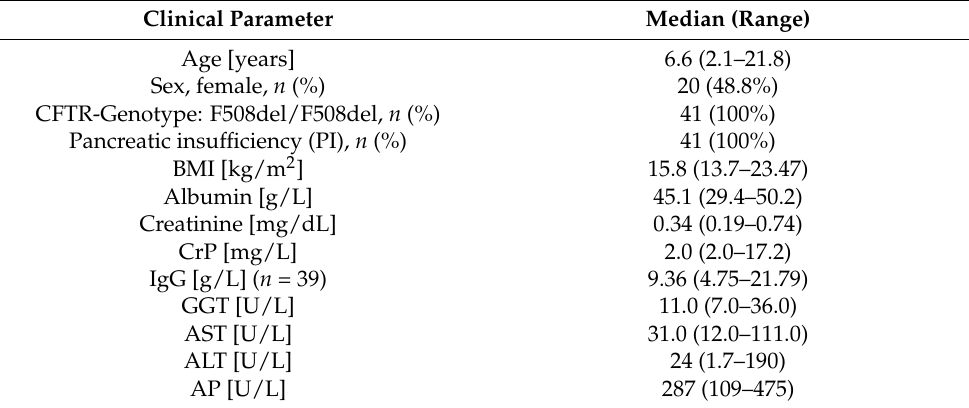
Table 1. Characteristics at baseline in 41 patients with cystic fibrosis (CF). Clinical Parameter